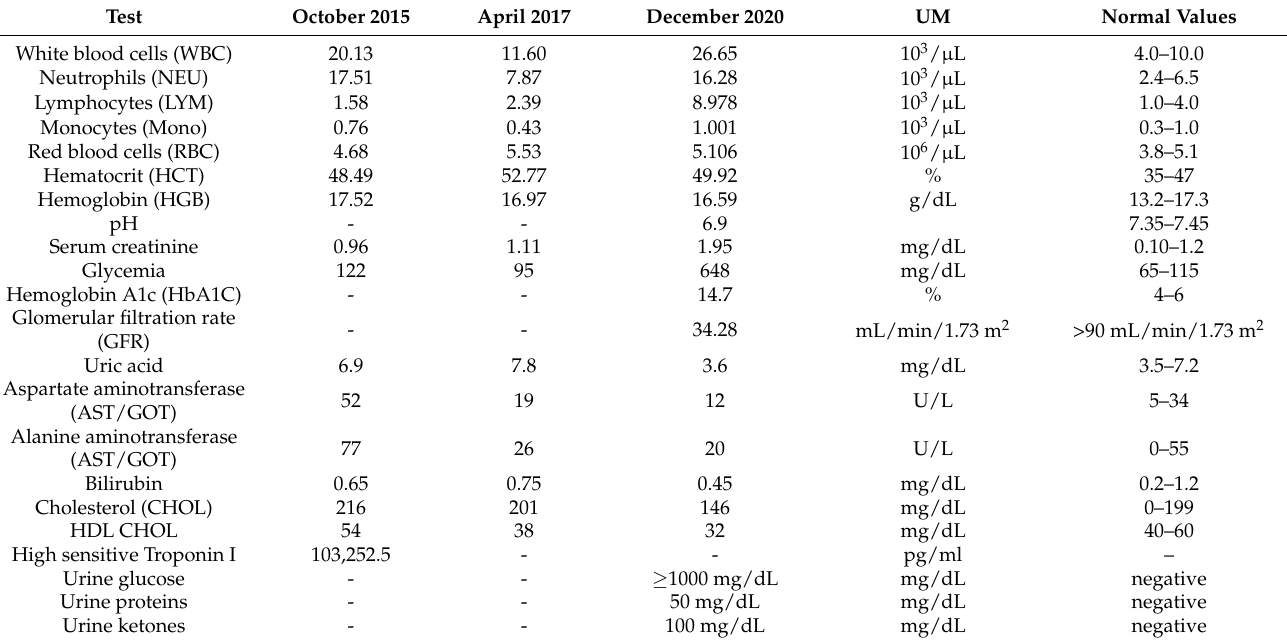
Table 1. A comparison of the laboratory results recorded at the time of